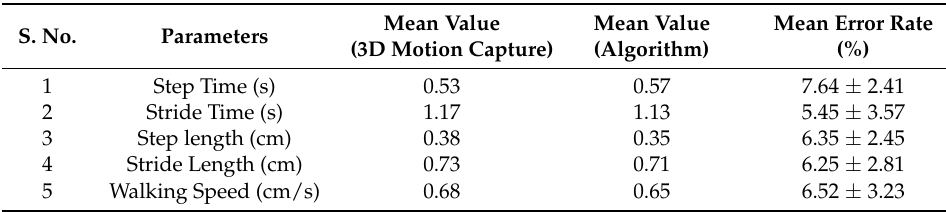
Table 2. Mean value of gait parameters obtained from wearable accelerometer-based estimation and 3D motion capture